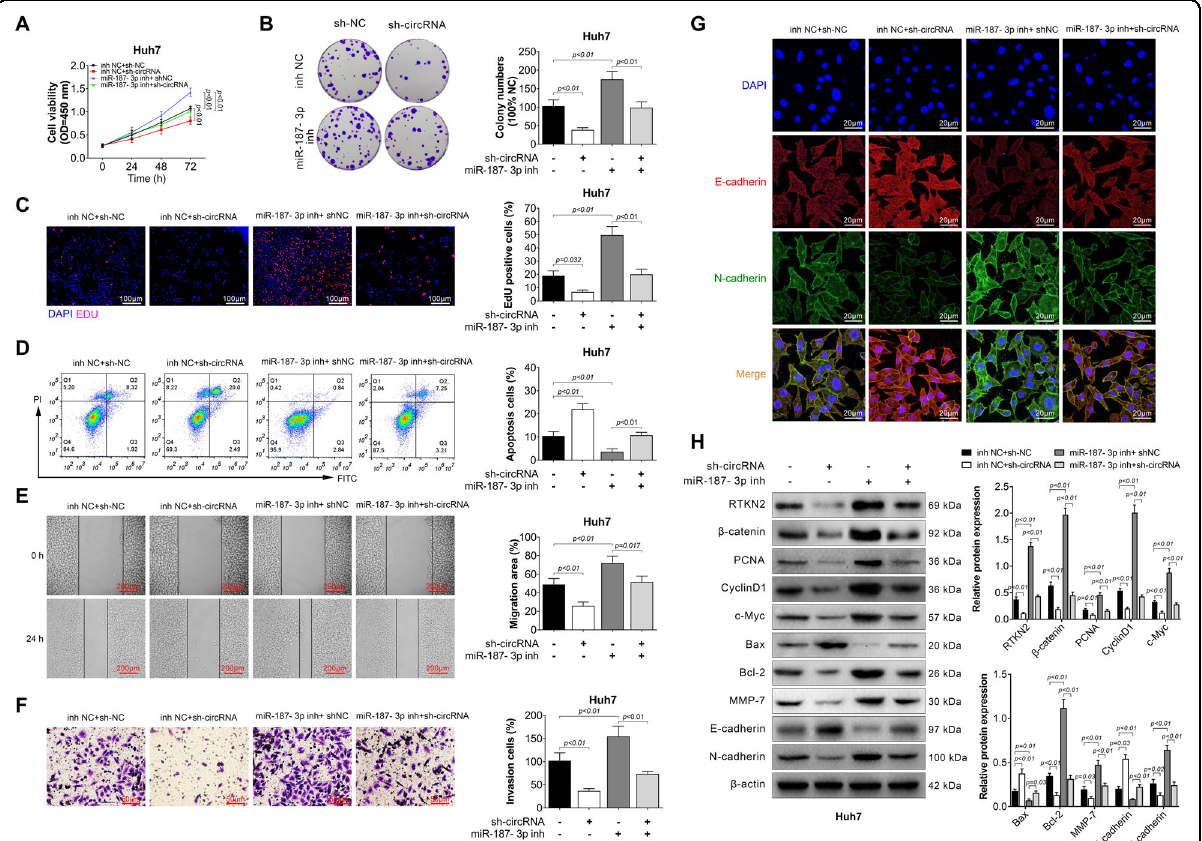
Fig. 6 Hsa_circ_104348 regulated miR-187-3p to affect proliferation, migration, invasion, and apoptosis of HCC cells, and may have effect on Wnt/ β -catenin signaling pathway. Huh7 cells were co-transfected with sh-circRNA or sh-NC and miR-187-3p inhibitor or inhibitor NC: A and B Cell proliferation abilities were determined by CCK-8 assay ( A ) and colony formation assay ( B ). C and D Cell apoptosis was determined by EdU staining ( C ) and fl ow cytometry assay ( D ). The scale bars were 100 μ m. E and F Cell migration and invasion abilities were checked by wound healing assay ( E ) and transwell assay ( F ). The scale bars were 50 μ m. G The expression of E-cadherin, N-cadherin was determined by IF. The scale bars were 20 μ m. H The expression of RTKN2, β -catenin, PCNA, CyclinD1, c-Myc, Bcl-2, Bax, MMP-7, E-cadherin, N-cadherin was determined by western blot. Data were expressed as mean ±